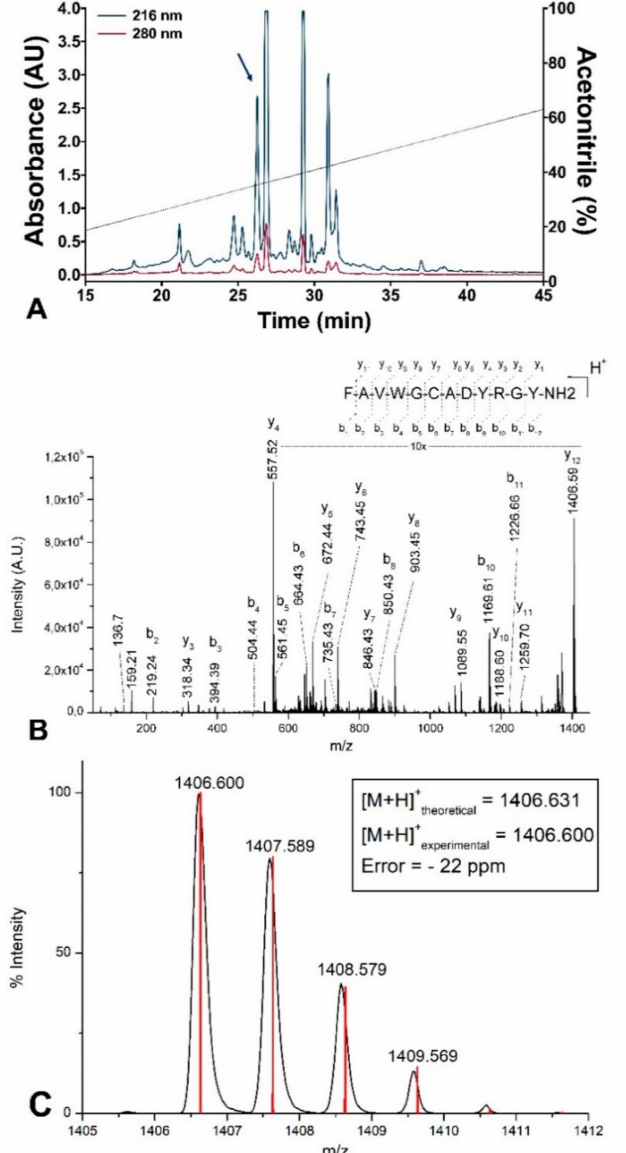
Figure 2. ( A ) Reversed-phase HPLC chromatogram of the crude extract from S. salamandra skin secretions. Sample absorbance was monitored at 216 (blue line) and 280 nm (red line). Fraction containing peak at retention time 26 min (blue arrow) corresponds to salamandrin I peptide. ( B ) MS / MS spectrum of salamandrin-I, [M + H] + = 1406.6 Da, acquired in an Ultraflex III MALDI TOF MS; amino acid sequence determined: FAVWGCADYRGY-NH 2 . ( C ) MS spectrum showing isotopic profile and predicted isotope abundance (red line) of salamandrin-I peptide. Square shows the calculated